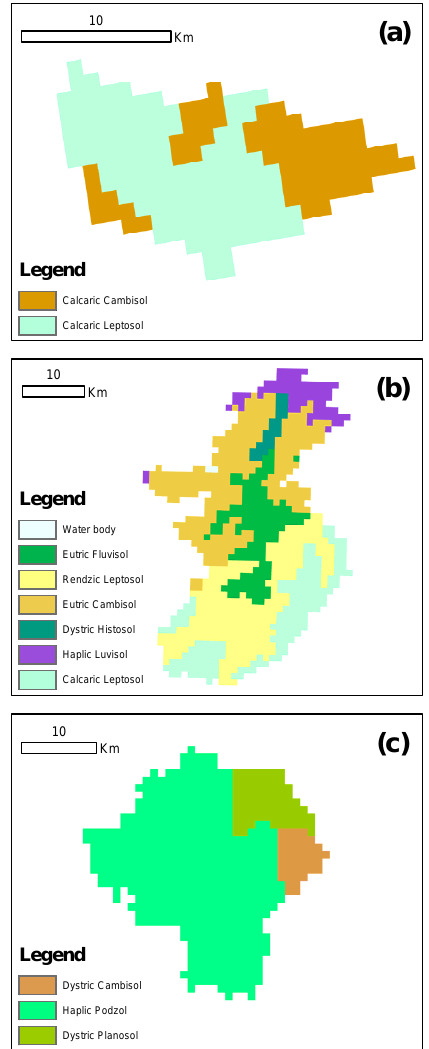
Fig. 2. Parent material hydrogeological types (1km × 1km raster library of the European Soil Database, Panagos et al., 2012) in the catchments: (a) Poyo, (b) Upper Iller and (c) Kamp. (Stor. – Perm. –=weakly or unconsolidated microporous substratum with a low permeability and storage capacity. Hard. Stor.–Perm.–=hard mas- sive rock with negligible permeability and storage capacity. Porous – Stor. ∼ Perm.+=hard, non- or weakly porous limestone, sand- stone and crystalline rock with moderate storage capacity and high permeability because of well developed fissure/joint systems).